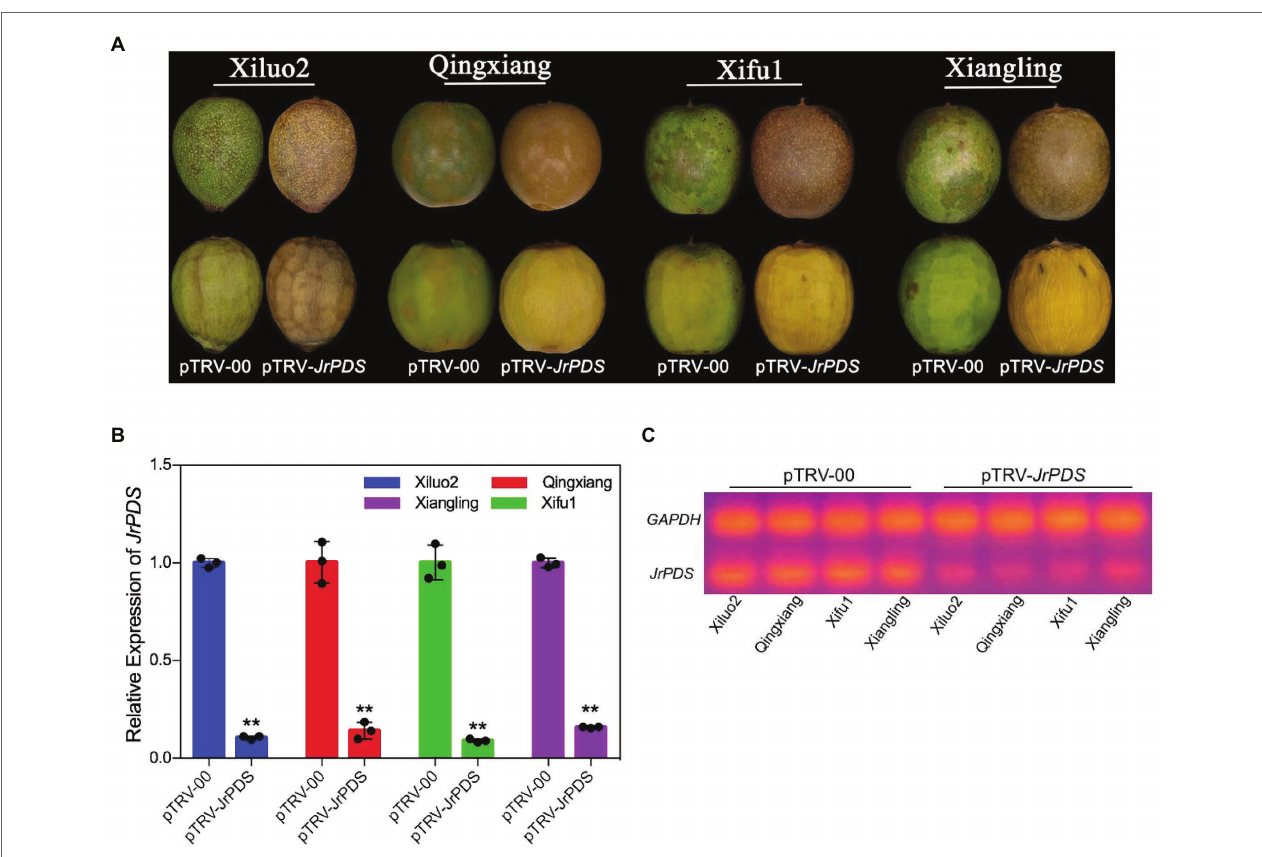
FIGURE 2 | Schematic representation of the TRV genomes and the JrPDS silencing in J. regia fruits at 10 dpi. (A) JrPDS silencing in J. regia fruit hull. The fruits of four J. regia cultivars (cv. Xiluo2, Qingxiang, Xifu1, and Xiangling) were inoculated in vitro . The image shows the phenotype of fruits infected with pTRV-00 and pTRV- JrPDS . (B) The relative expression levels of JrPDS in pTRV- JrPDS -infected walnut fruits at 10 dpi. pTRV-00-infected fruits were used as control, and the mean of three biological repeats was calculated for individual assays. Bars indicate SD, and asterisks indicate statistically significant differences relative to the control values (Student’s t -test; ** p ≤ 0.01). (C) RT-PCR detecting JrPDS gene